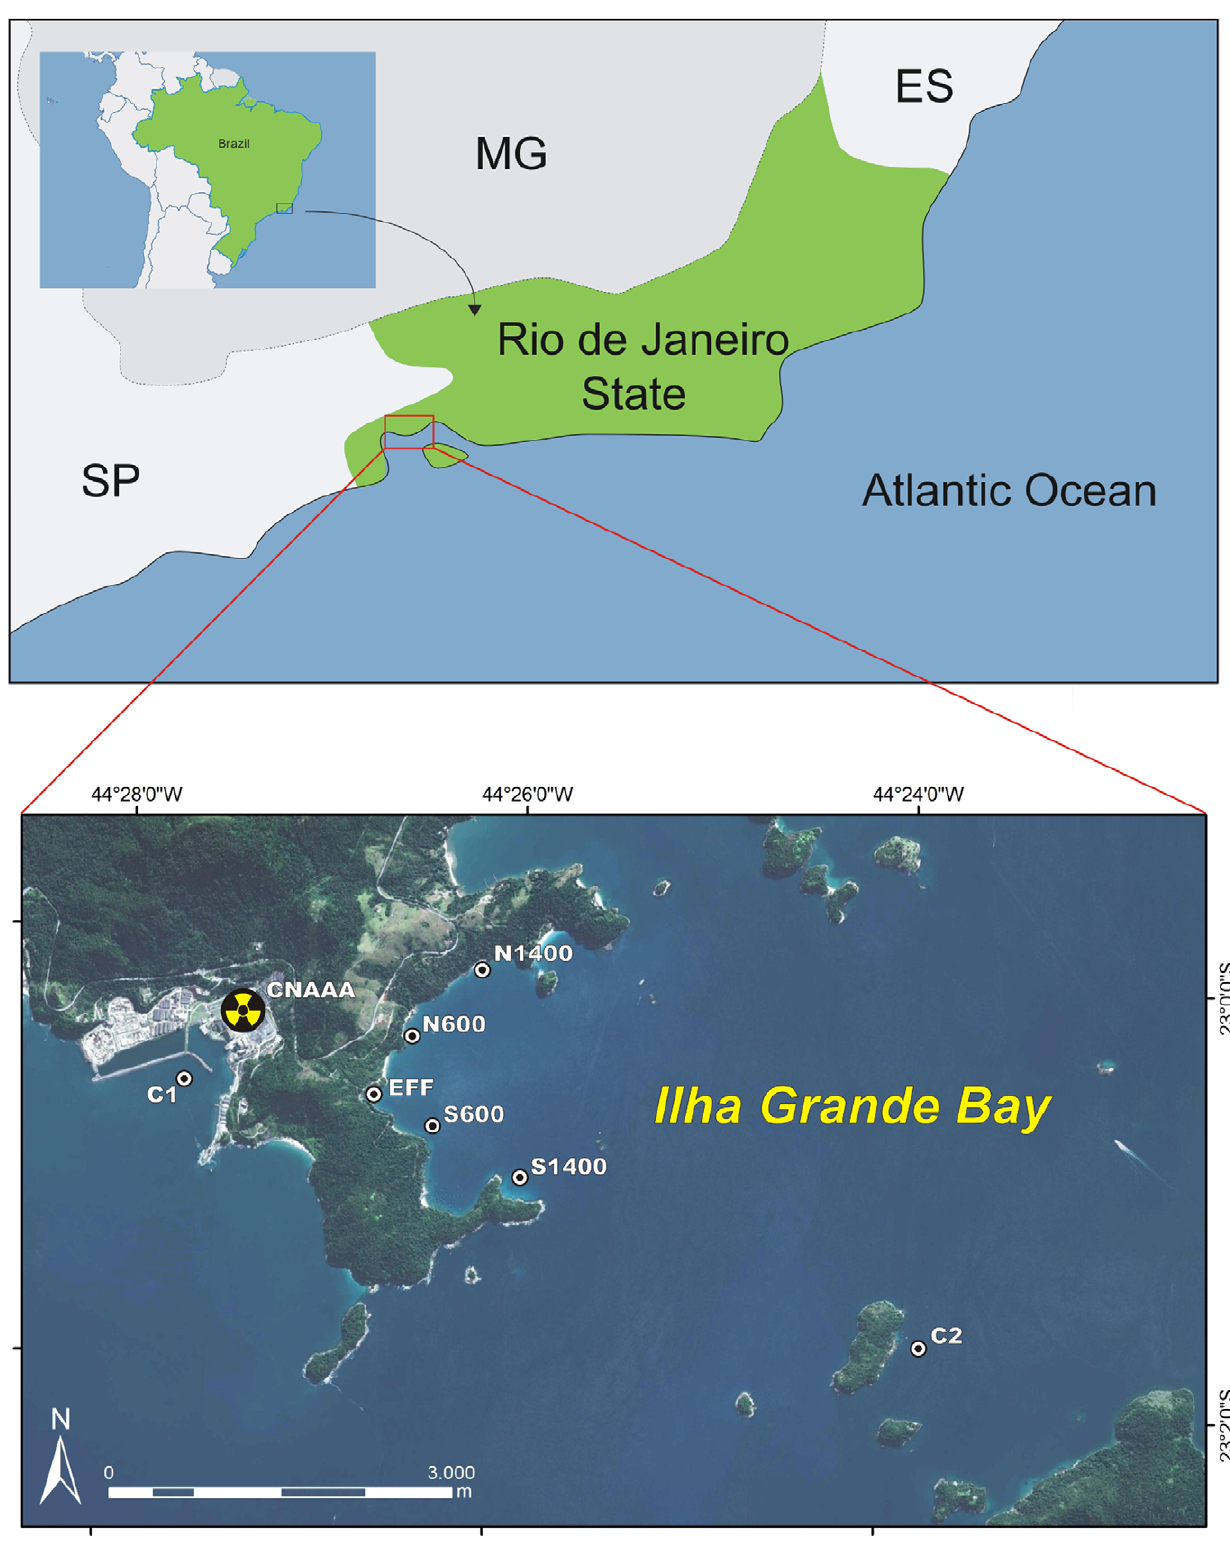
Figure 2. Map of the location of the CNAAA power plant and the sites sampled. Effluent (Eff) –100 m far from the discharge point of the power plant; 600 m sites (N600 and S600) – one on each side of the bay, 600 m far from the discharge point; 1400 m sites (N1400 and S1400) – one on each side of the bay, 1400 m far from the discharge point; Control 1 (C1) – the intake area of the cooling system, control area; Control 2 (C2) – located on the East side of Branda˜o Island, control area.